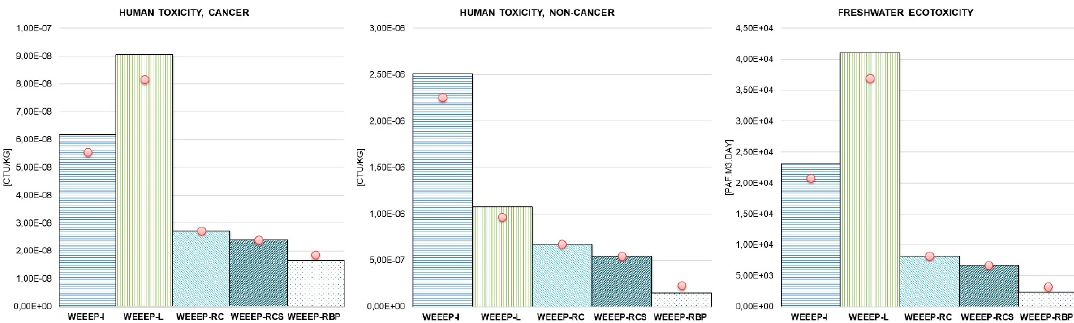
Figure 6. Environmental impacts associated with the five end-of-life scenarios (WEEEP-I, WEEEP-L, WEEEP-RD, WEEEP-RCS, and WEEEP-RBP) for 1 kg of e-plastic treatment residues including the influence of the sensitivity options (S1). Shown are the USEtox mid-point results for the impact categories “human toxicity, cancer”, “human toxicity, non-cancer”, and “freshwater ecotoxicity”.